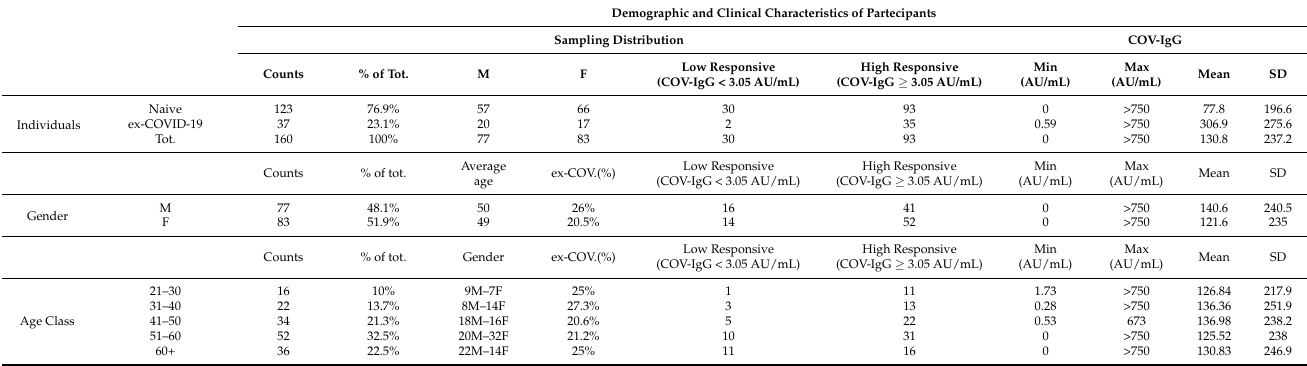
Table 1. Demographic distribution and anti-SARS-CoV-2 IgG plasma levels of participants. Whole blood samples were collected from 160 healthcare workers at a large medical center in Southern Italy. All participants are Caucasian people from the same geographic area, and 52% of them were female. The median age was 50 years, and 23% of individuals ( N = 37) were former COVID-19 patients (ex-COVID-19), completely negative to SARS-CoV-2 molecular testing for at least for two months at the time (day 0) of BNT162b2 mRNA vaccine administration. Among the seronegative participants at day 0 (naïve), we distinguished low ( N = 30) and high ( N = 93) responsive individuals based on the lower 10th percentile of anti-SARS-CoV-2 IgG sampling distribution, which set the cut-off point at 3.05 AU/mL, as determined by the SARS-CoV-2 IgG ADVIA Centaur immunological assay (Siemens